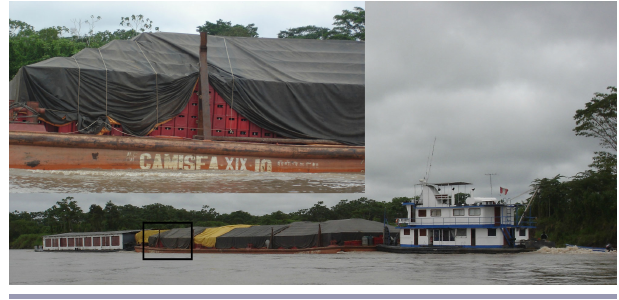
Fig. 2 . Pictures of a Pluspetrol’s barge, named Camisea (from the name of the most important gas concession in Peru that is also operated by Pluspetrol), carrying large amounts of cases of (Corrientes River, 14 October